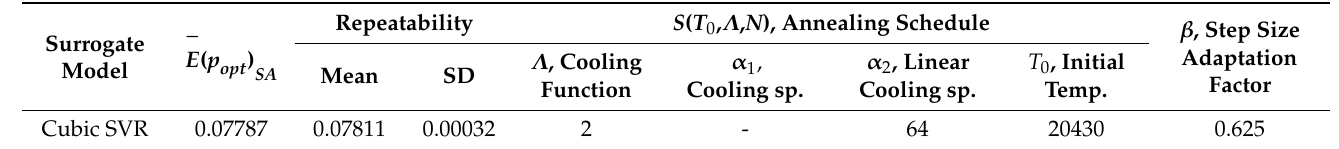
Table 9. Tuned SA parameters for the SVR surrogate model.